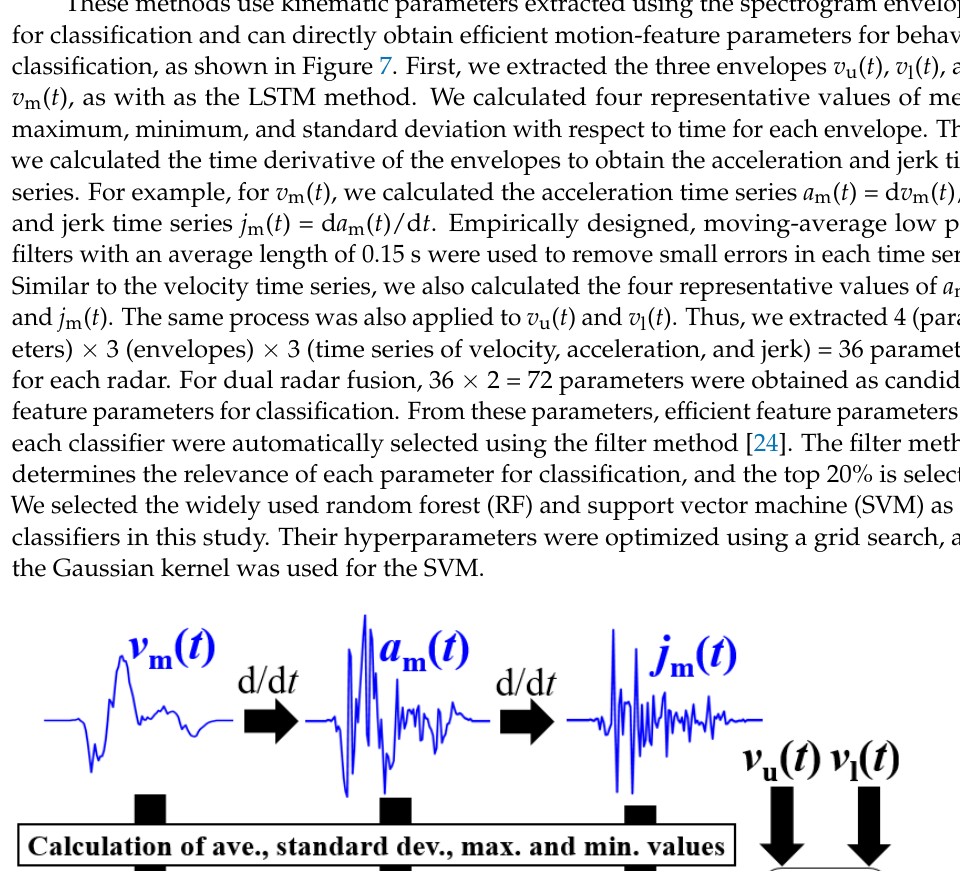
Figure 6. Process and structure of the LSTM method.